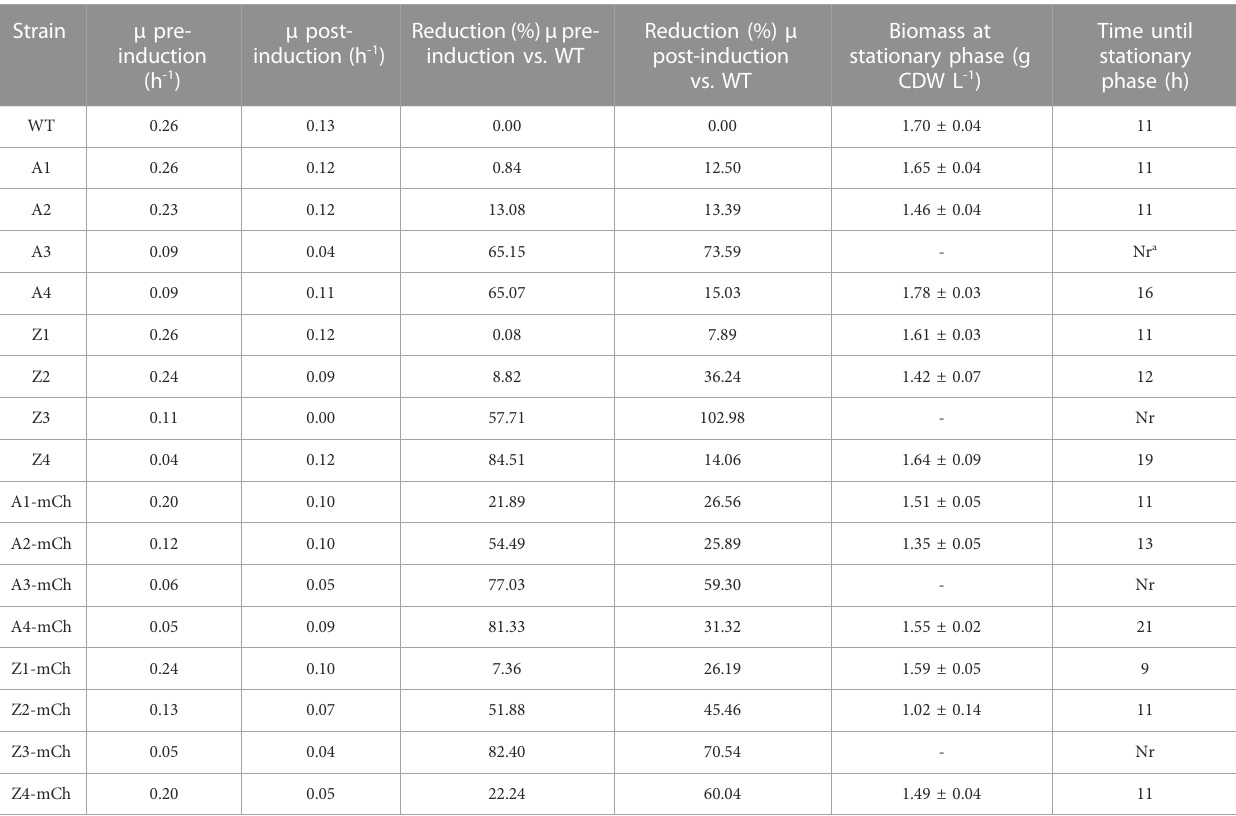
TABLE 2 Summary of results from cultivations in Biolector Pro microbioreactors with WT Escherichia coli BL21 and the sixteen recombinant strains studied in this work. Indicated in the table are average speci fi c growth rates (µ; h -1 ) at exponential phase before (pre-induction) and after (post-induction) addition of m-toluate (average ±SD); reduction (%) in µ pre- and post-induction, referred to WT; biomass (g CDW L -1 ) at stationary phase (average ±SD); and time to reach stationary phase (h after inoculation).